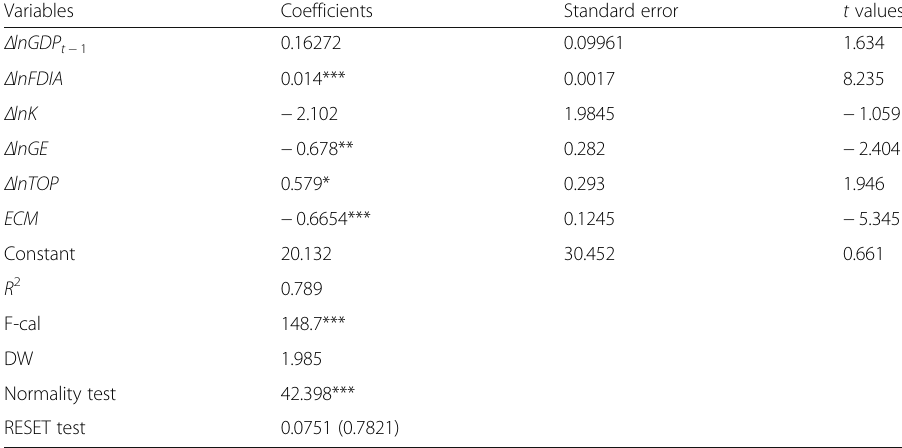
Table 6 Results of the ECM model